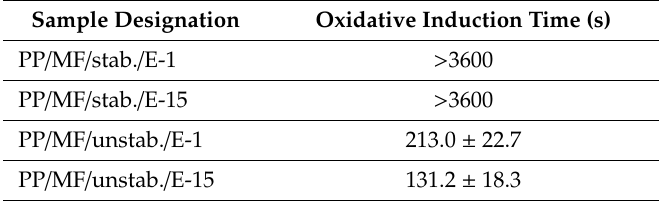
Figure 3. Filament tensile strength as a function of the number of extrusions for both composites ( a ); and scanning electron microscopy images of the cryofractured filaments of PP / MF / stab. / E-1 ( b ), PP / MF / unstab. / E-1 ( c ), PP / MF / stab. / E-15 ( d ), and PP / MF / unstab. / E-15 ( e ). Table 2. Oxidative induction time at 200 °C for the composites investigated.